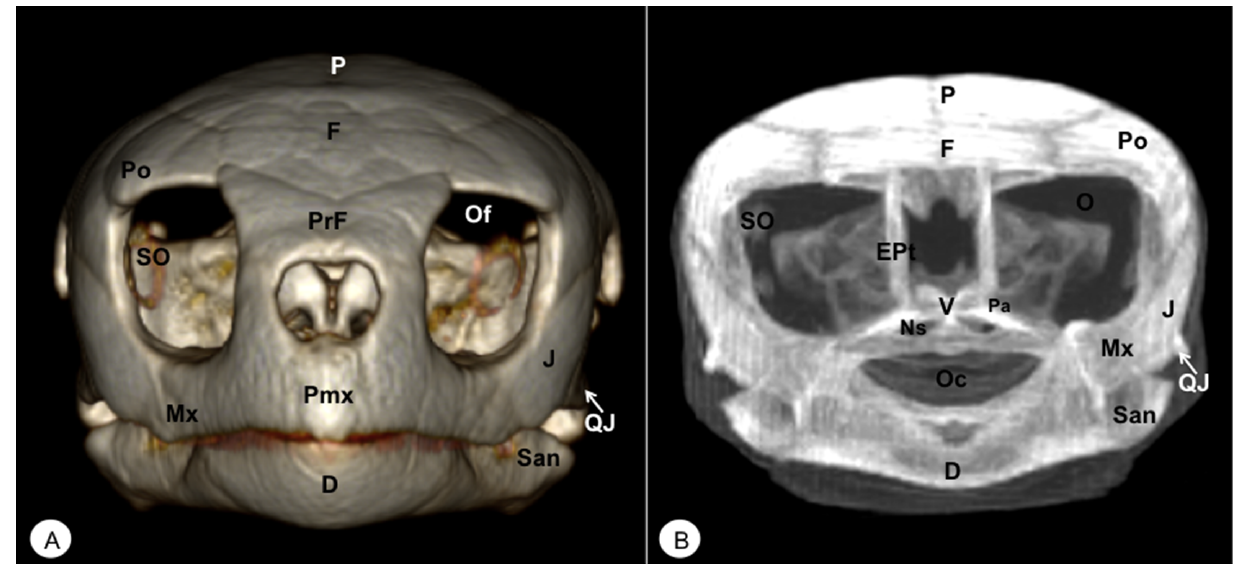
Figure 2. Head of Caretta caretta . ( A ) Rostral VR image. ( B ) Rostrotransversal MIP image. Pmx: Premaxillary bone. PrF: Prefrontal bone. F: Frontal bone. Po: Postorbital bone. O: Orbit. Of: Orbital fossa. J: Jugal bone. QJ: Quadratojugal. Mx: Maxillary bone. SO: Scleral ossifications. P: Parietal bone. EPt: Epipterygoid bone. V: Vomer. Pa: Palatine bone. Ns: Nasal sinuses. Oc: Oral cavity. D: Dentary. San: Surangular.